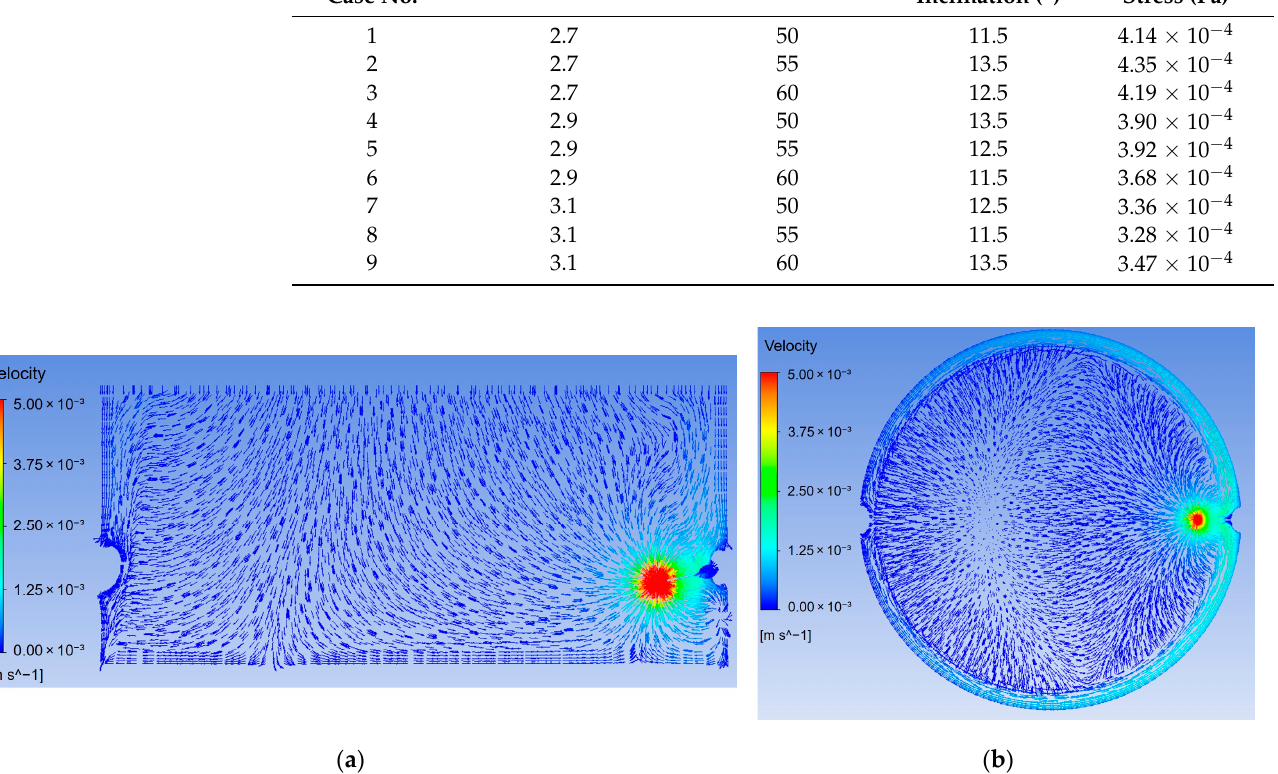
Figure 8. Iron flow fields of No. 7 case: ( a ) in the xz cross section through taphole and ( b ) in the xy cross section with 1.5 m height from the hearth bottom.